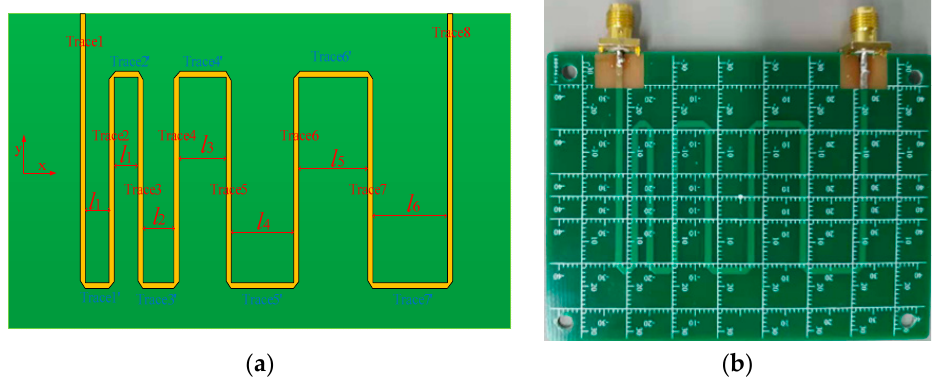
Figure 24. ( a ) Layout of the meander line. l 1 = 2 mm, l 2 = 4 mm, l 3 = 6 mm, l 4 = 8 mm, l 5 = 10 mm, and l 6 = 12 mm. ( b ) Photo of the meander line.